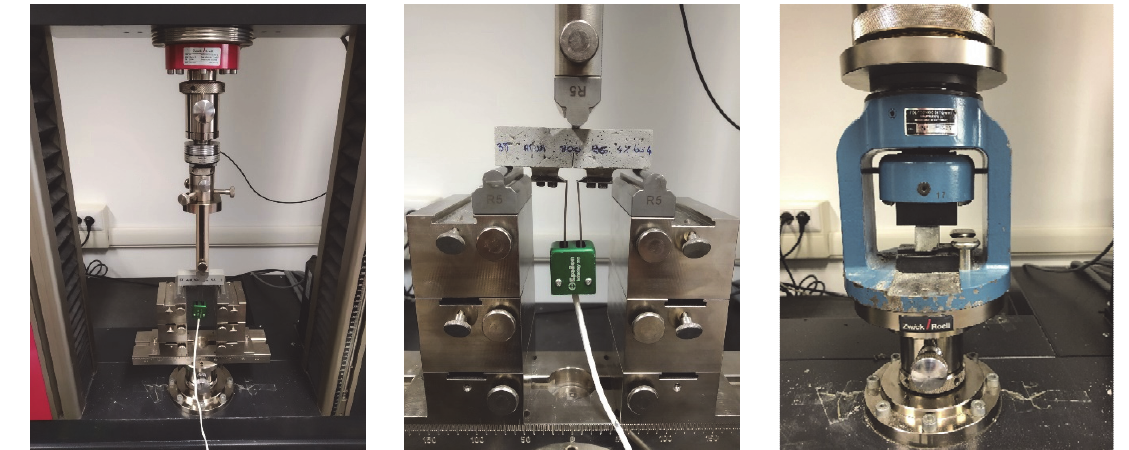
Figure 3: Flexural tests with CMOD measurements on notched prisms (left), detail of the clip-on strain gauge (centre) and compression test on halves of the broken prism